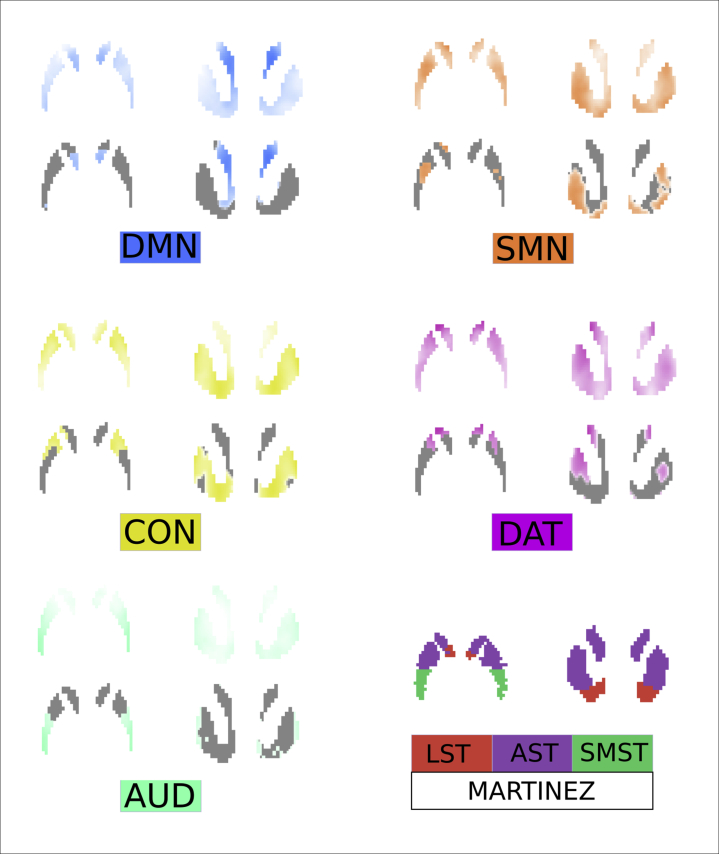
Connectivity-defined striatal maps. Striatal connectivity maps were used to weight voxelwise Kicer maps and generate network-specific Kicers. Group-averaged maps are shown, whereas individualized maps were used in practice. Maps are normalized by total connectivity strength. Greater intensity of color indicates that a voxel displays greater connectivity to the cortical network in question. In order to show differences between networks more clearly, thresholded maps are also shown (retaining only top 35% of voxels). The anatomically defined Martinez et al. (30) parcellation is also shown at the bottom right. AST, associative striatum; AUD, auditory network; CON, cingulo-opercular network; DAT, dorsal attention network; DMN, default mode network; LST, limbic striatum; SMN, sensorimotor network; SMST, sensorimotor striatum.